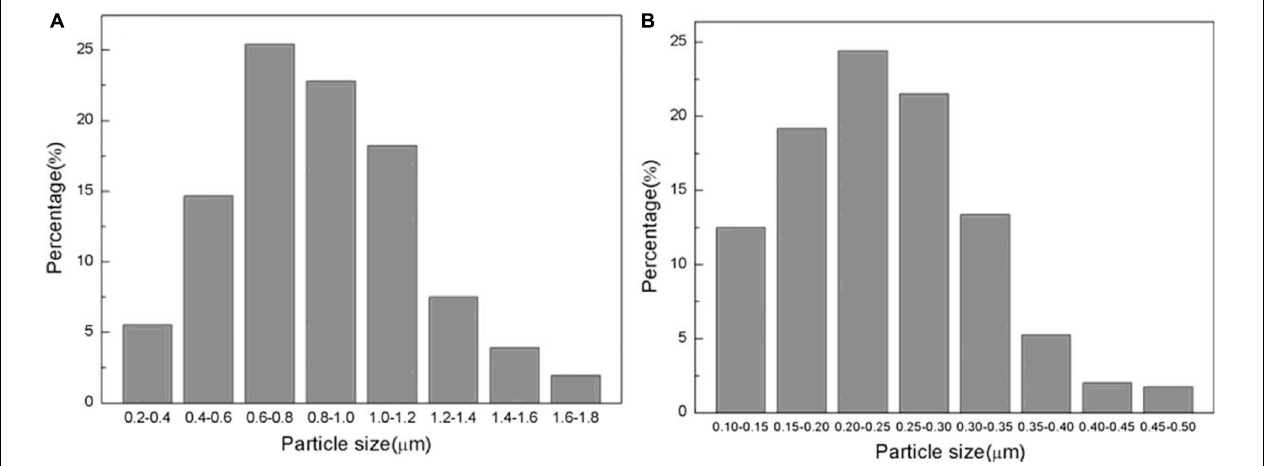
FIGURE 12 | Particle distributions of (A) WC and (B) WC-As powders after 2 h of carbonization at 1400 ◦ C (Wang et al., 2018) [Figure 13 of Wang et al. (2018), Copyright Elsevier B.V. and The Society of Powder Technology Japan].